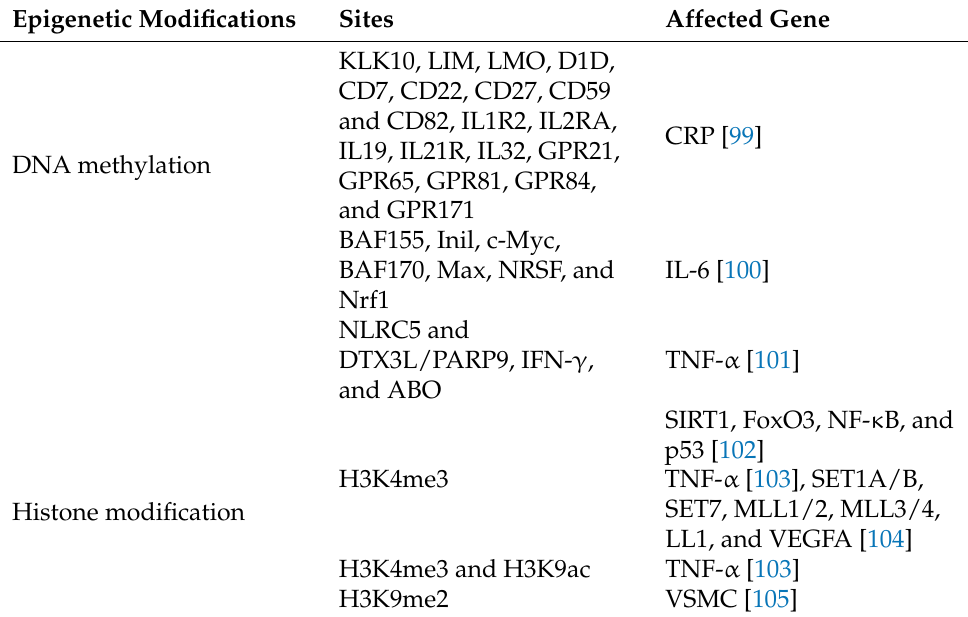
Table 2. Summary of the most relevant epigenetics changes and inflammation processes in CVD.